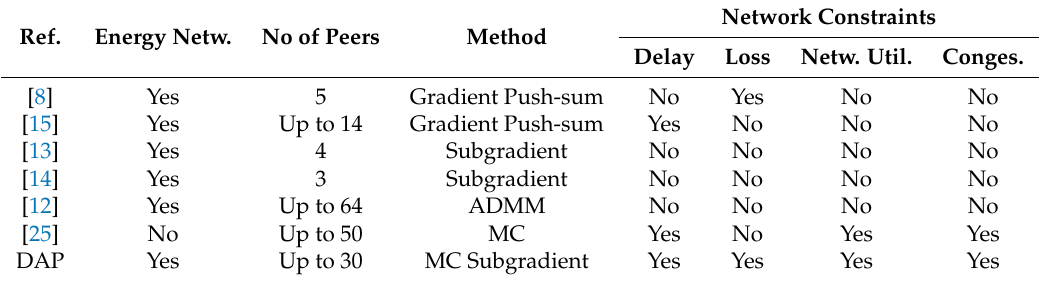
Table 1. Review of Relevant Literatures. Netw. Util: Network Utilization; Conges.: Congestion; ADMM: Alternating direction method of multipliers; MC: Multicommodity.